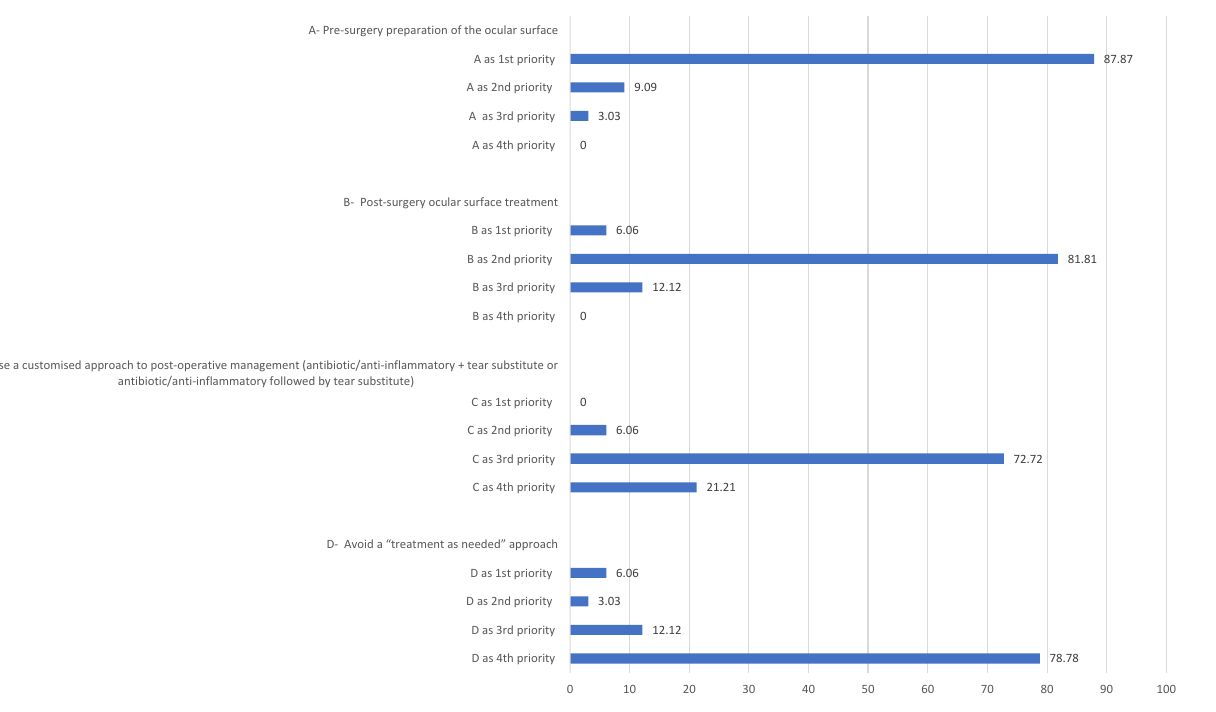
Figure 3. The ranking of the priorities attributed to the two statements related to managing the ocular surface in surgical